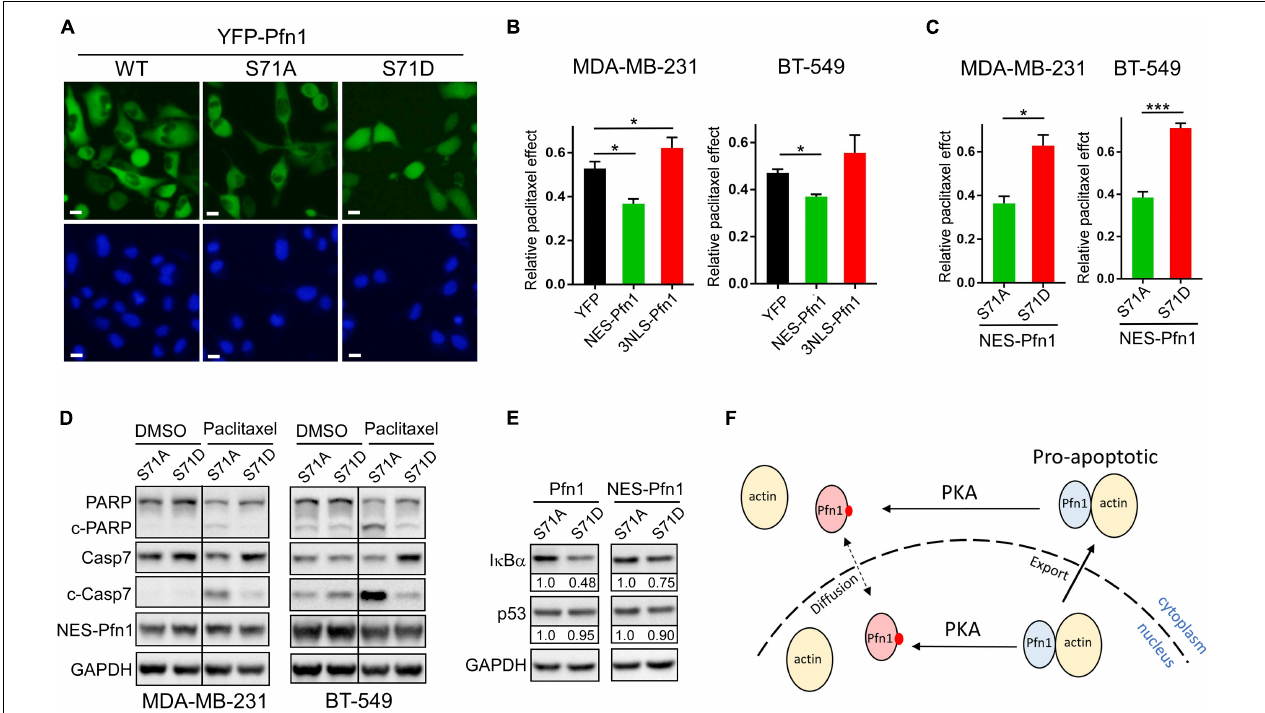
FIGURE 6 | Apoptotic sensitization by Pfn1 requires actin-binding and cytoplasmic localization. (A) Direct fluorescence imaging of MDA-MB-231 stably infected with wild type or mutant YFP-Pfn1. Scale bars represent 20 µ m. (B) Stable MDA-MB-231 and BT-549 cells expressing YFP, NES-Pfn1, or NLS-Pfn1 were subjected to colony formation assays in 24-well plates with vehicle (DMSO) or 0.5 nM paclitaxel for 7 days. Relative drug effects were calculated as the ratios between cell numbers (based on Alamar blue values) in the paclitaxel-treated vs. vehicle conditions. (C) Stable MDA-MB-231 and BT-549 cells expressing NES-Pfn1(S71A) or NES-Pfn1(S71D) were treated with vehicle or paclitaxel in colony formation assays and analyzed as in (B) . Data are mean ± SEM of three technical replicates in one biological experiment. Similar results were observed in three independent experiments. P -values were based on two-tailed unpaired t -test. * p < 0.05; *** p < 0.001. (D) MDA-MB-231 and BT-549 stable cells expressing NES-Pfn1(S71A) or NES-Pfn1(S71D) were treated with DMSO or 5 nM paclitaxel for 48 h, and analyzed for full-length or cleaved PARP and caspase-7, YFP-NES-Pfn1 (with GFP ab) and GAPDH by Western blot. (E) MDA-MB-231 stable cells expressing untagged or NES-tagged Pfn1(S71A) vs. Pfn1(S71D) were treated with 10 nM paclitaxel for 48 h, and analyzed for I κ B α , p53, and GAPDH by Western blot. (F) Hypothetical model for the pro-apoptotic activity of cytoplasmic Pfn1 which requires actin-binding and is abolished by PKA-dependent Ser 71 phosphorylation. Ser 71 may also